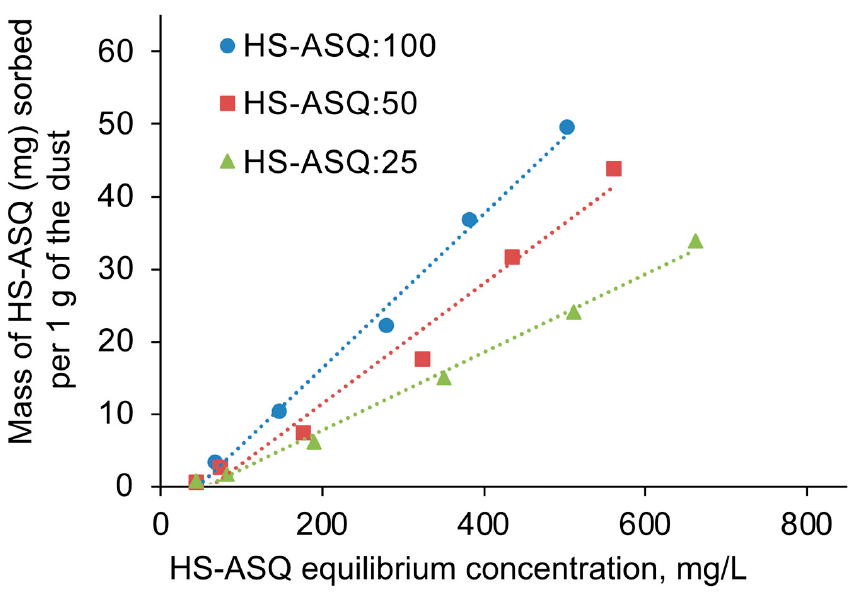
Figure 6. HS–ASQ sorption isotherms onto dust (pH 8.0, 0.1 g of dust per 10 mL of HS–ASQ solution, equilibrium time 24 h, 25 °C).